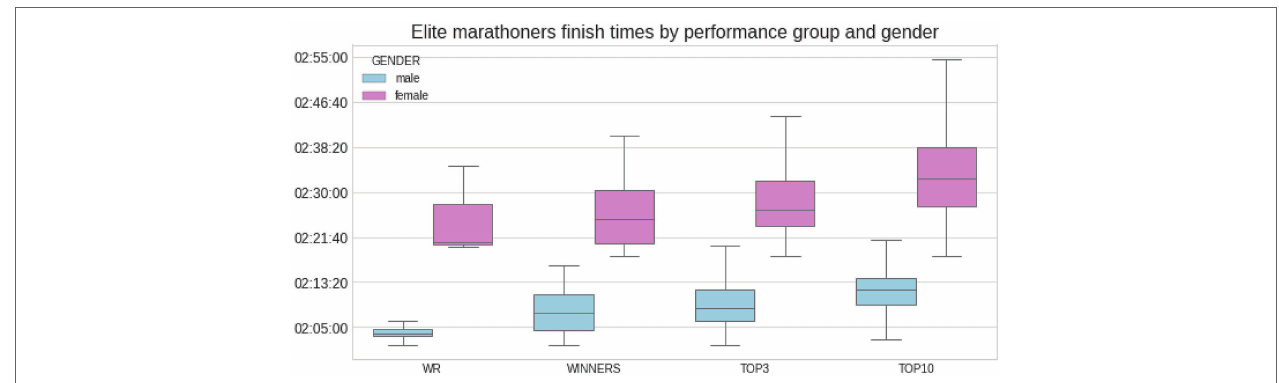
FIGURE 1 | Marathon finishing times from world record (WR) performances and elite athletes (winner, top three, and top 10) by gender, with SD. Around 95% CI was used to create the boxplots. Statistical differences between male and female performances among all groups p < 0.05 and within sexes between WR and top three and top 10